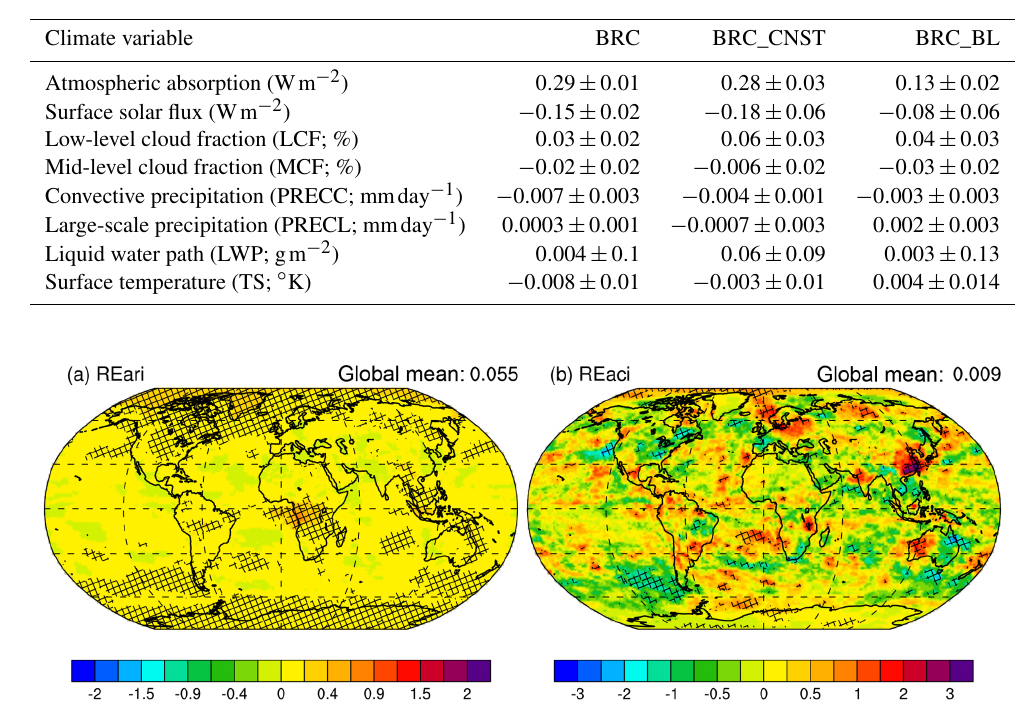
Table 4. Global averages over the period 2003–2011 for select climate variables from BRC, BRC_CNST, and BRC_BL. Standard deviations from the five-ensemble means are included.